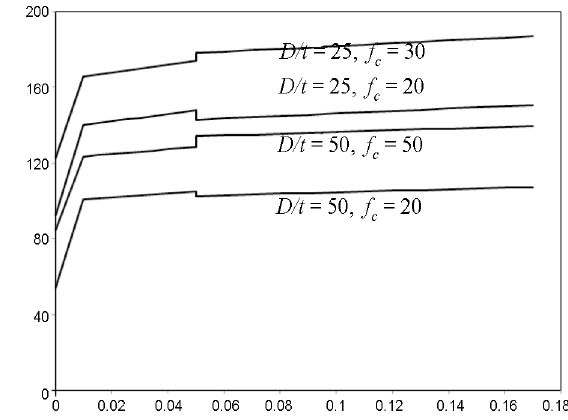
Fig. 9. Relationship of compressive strength of confined f ) versus prestressing ratio ( concrete ( cc